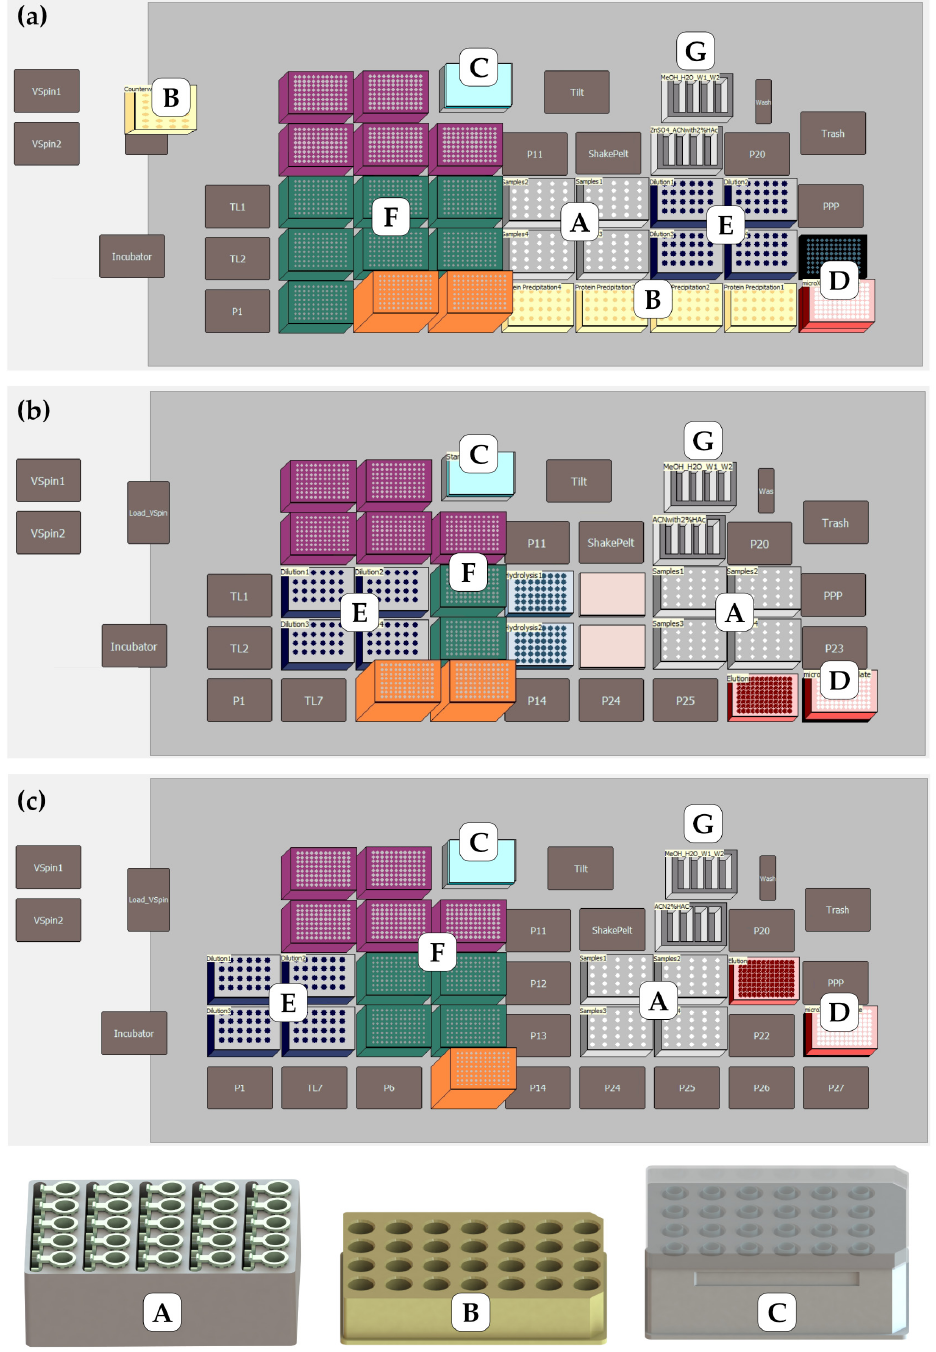
Figure 3. ( a ) Deck layout serum ( b ) Deck layout urine ( c ) Deck layout saliva (A) Adapter for Eppen- dorf Vials (B) Adapter for Protein Precipitation (C) Aluminum Adapter for Internal Standards (D) Strata X-C µElution 96-well SPE plate and 96-well elution plate (E) Aluminum adapter with 1.5 mL vials for dilution (F) Tip boxes (G)